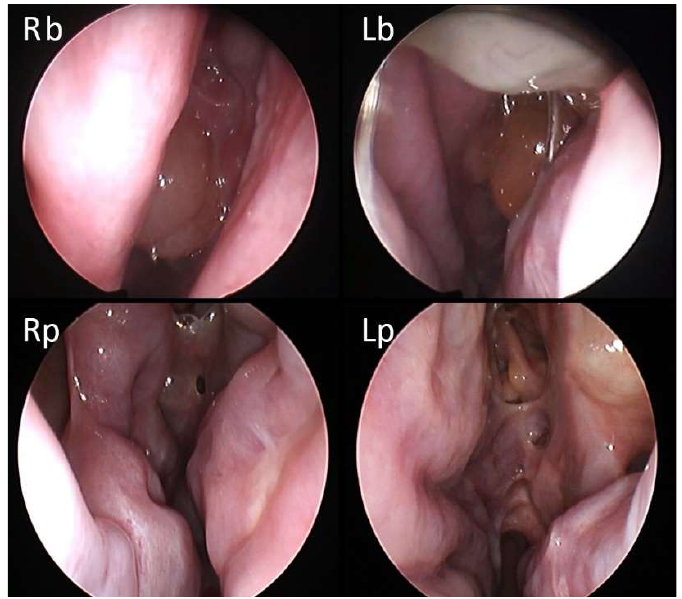
Figure 6. 46-year-old male patient with medical history of 5 previous surgeries and persistent mixed neutrophilic eosinophilic infiltration at nasal cytology. Affected by severe OSAS and obesity, the patient was at increased anesthesiologic risk for a new surgery. At baseline, the NPS was 5/8 (Rb: right side at baseline; Lb: left side at baseline). After one month of therapy with dupilumab, polyps showed complete regression (Rp: right side post therapy; Lp: left side post therapy).